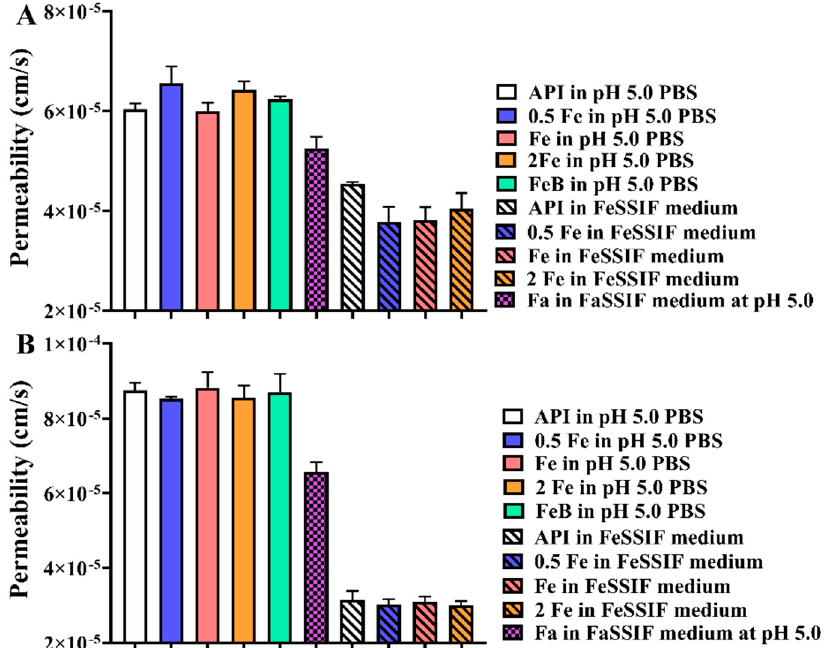
Figure 8. The permeability of different precipitates in different media. ( A ): Rivaroxaban; ( B ): Drug-A. (FeB, Fa, 0.5 Fe, Fe, and 2 Fe indicate that precipitate comes from the medium of FeSSIF buffer, FaSSIF, 0.5 × FeSSIF, FeSSIF, and 2 × FeSSIF,